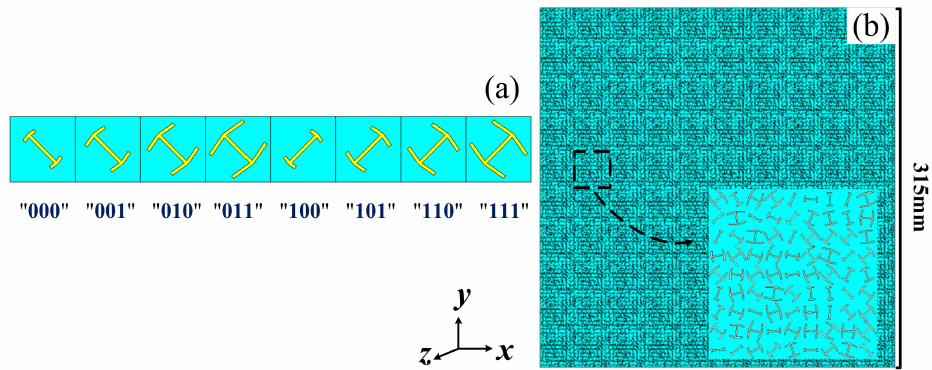
Figure 8. ( a ) Eight basic units, ( b ) the 3-bit coding metasurface.